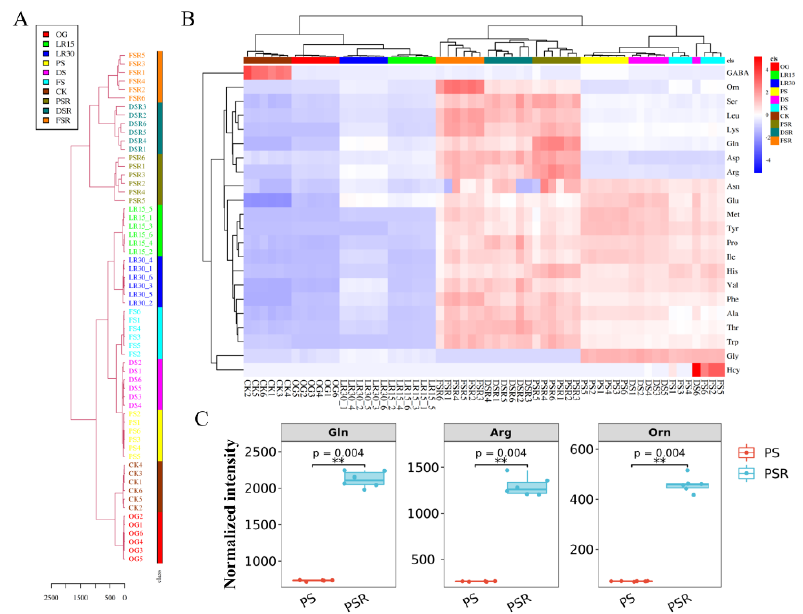
Figure 2. AAs targeted metabolomics of H. marmoreus at different developmental stages. ( A ) Hierarchical cluster of AAs. ( B ) Targeted profiling of the AA metabolome of H. marmoreus at different developmental stages . ( C ) Statistical tests of the top three AAs with the highest concentrations. ** represents p < 0.001.